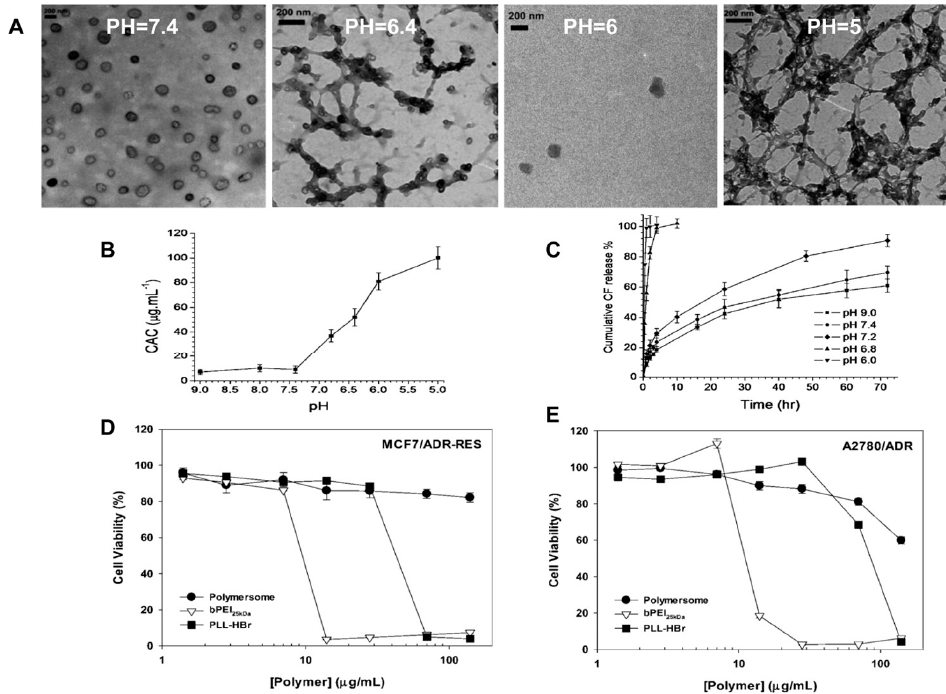
Figure 14. ( A ) TEM micrographs of the mPEG-b-(polyHis)2 polymer nanostructures at different pH. ( B ) The critical association value (CAC) as a function of pH. ( C ) In vitro release pro fi les of the encapsulated CF in the polymersome at different pH. ( D , E ) Cytotoxicity of polymersomes and representative polycations against MCF7/ADR-RES and A2780/ADR cells after 5 days incubation [192] (Copyright 2012, The Royal Society of Chemistry).